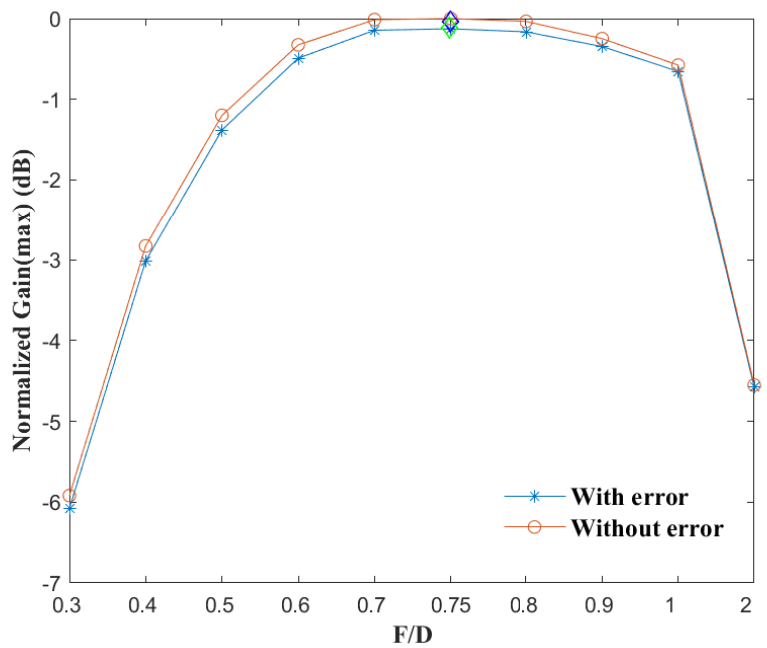
Figure 6. Peak gain of each F / D with d = 0.1 λ (lateral) and d = 0